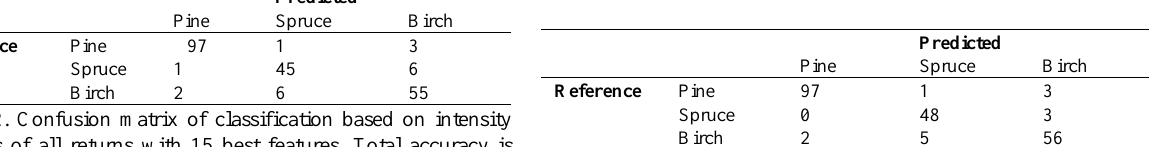
Table 4. Confusion matrix of classification based on intensity features and point cloud features of first returns with 15 best features. Total accuracy is 90.7%.